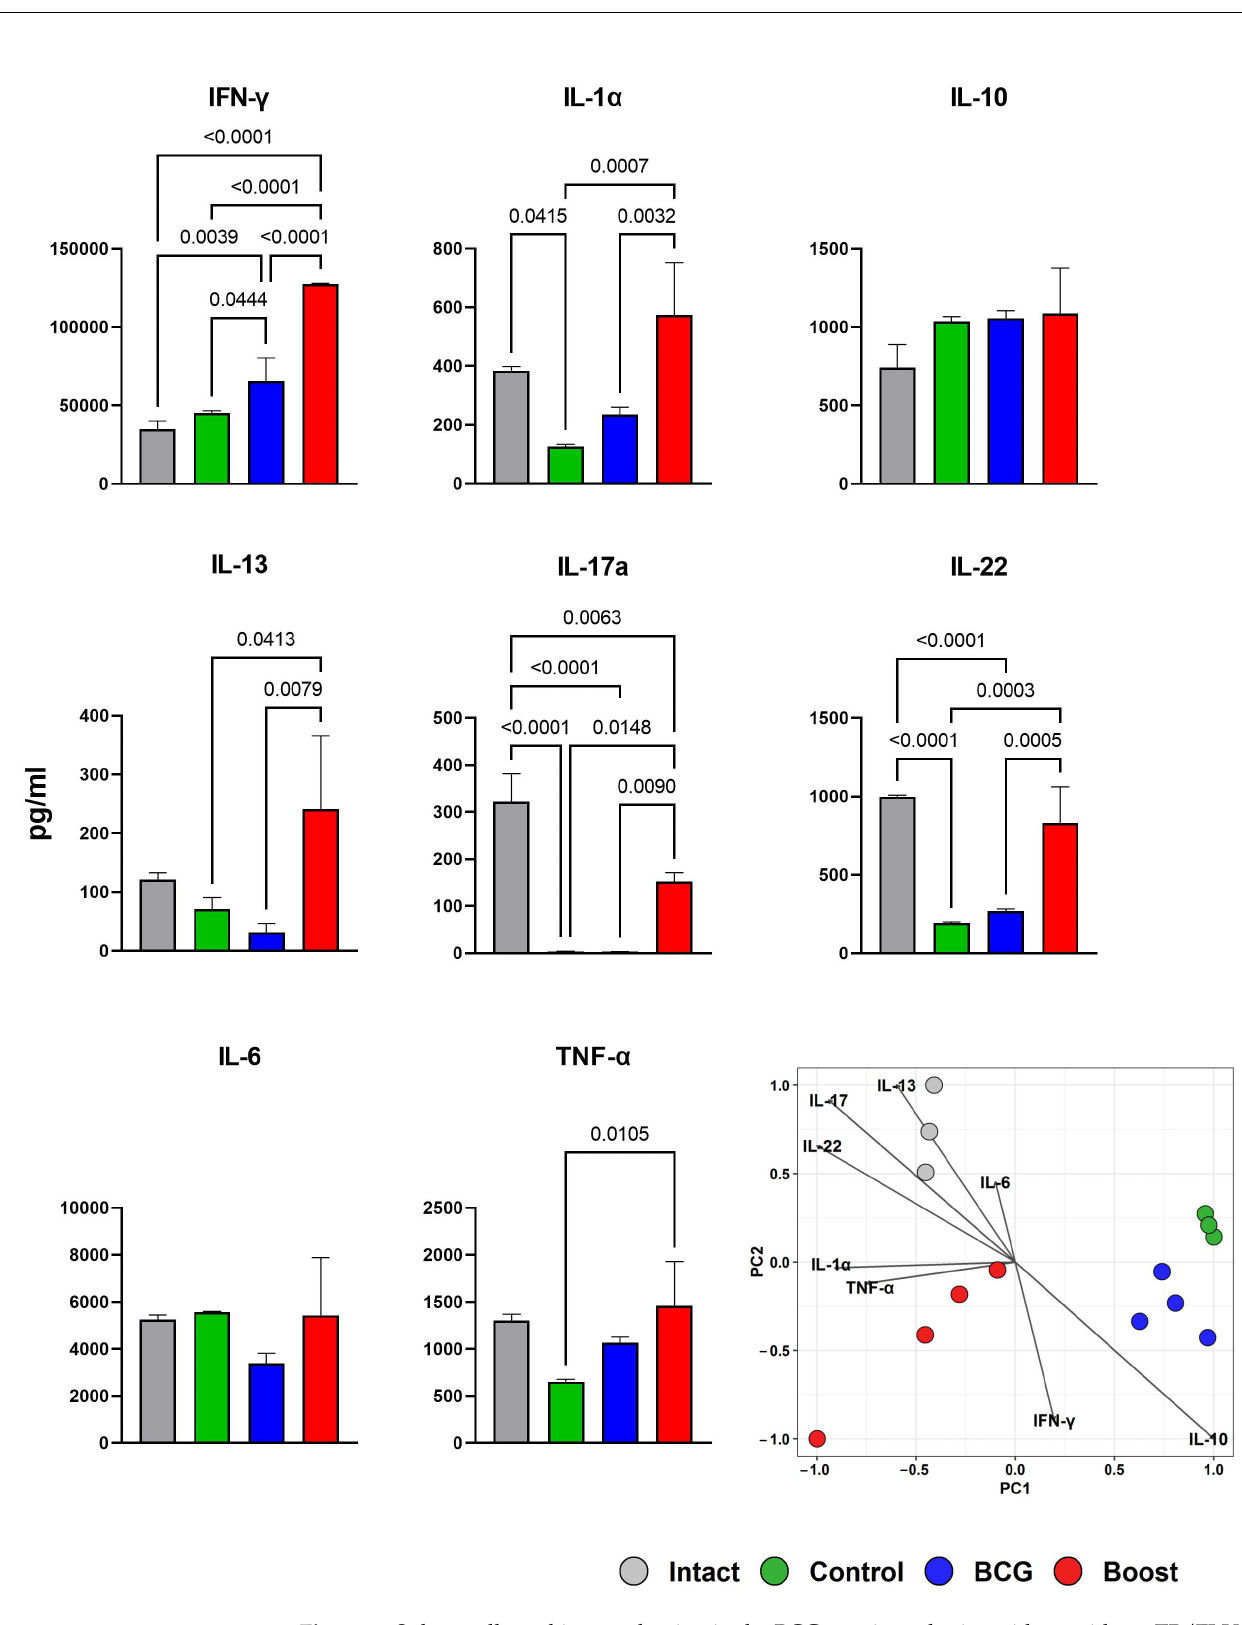
Figure 7. Spleen cell cytokine production in the BCG-vaccinated mice with or without TB/FLU-04L boost after M. tuberculosis infection. Four weeks after the i.v. challenge, spleen cells from intact (gray bars), control non-vaccinated mice (green bars), BCG-vaccinated mice (blue bars), or BCG- vaccinated/TB/FLU-04L-boosted mice (red bars) were cultured in the presence of medium only, ConA (2.5 µ g/mL), or BCG (5 µ g/mL). Levels of cytokines in the culture supernatants were